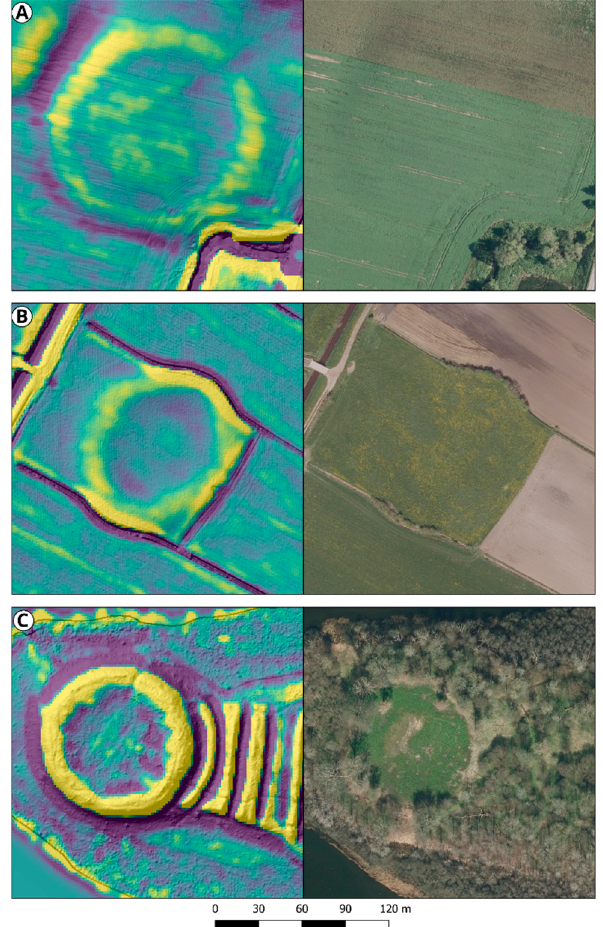
Figure 8. Detailed view of the known Viking Age site at Borgring ( A ) and candidate sites at Trælbanken ( B ) and Borgø ( C ) shown with both the residual relief model and orthophotography. All three sites have previously been identified as belonging to other periods, but are positively correlated as Trelleborg-type ring fortress candidates by our automatic feature detection approach. Only Borgring is now a recognized Trelleborg-type dated to the reign of Harald Bluetooth c. 958 to 986 CE .